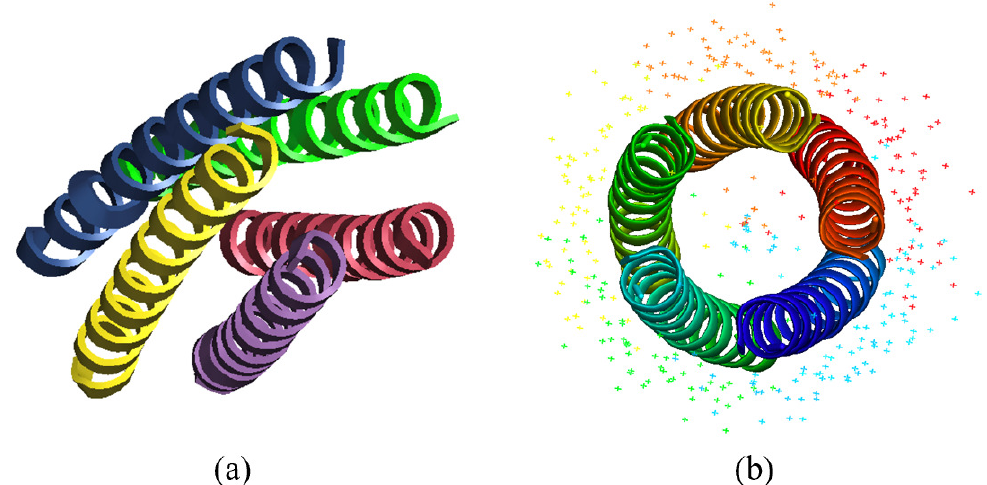
Figure 6. The protein molecule of 4uot has a five-fold rotational symmetry. Five copies have the same density related by a rotation symmetry. ( a ) A side view of the PDB posted model is shown as cartoon. ( b ) The rotation axis is perpendicular to the paper. The fixed water molecules on the protein surface are displayed. Starting from random phases, the reconstructed NCS mask evolves and finally covers the whole protein including most of the fixed water